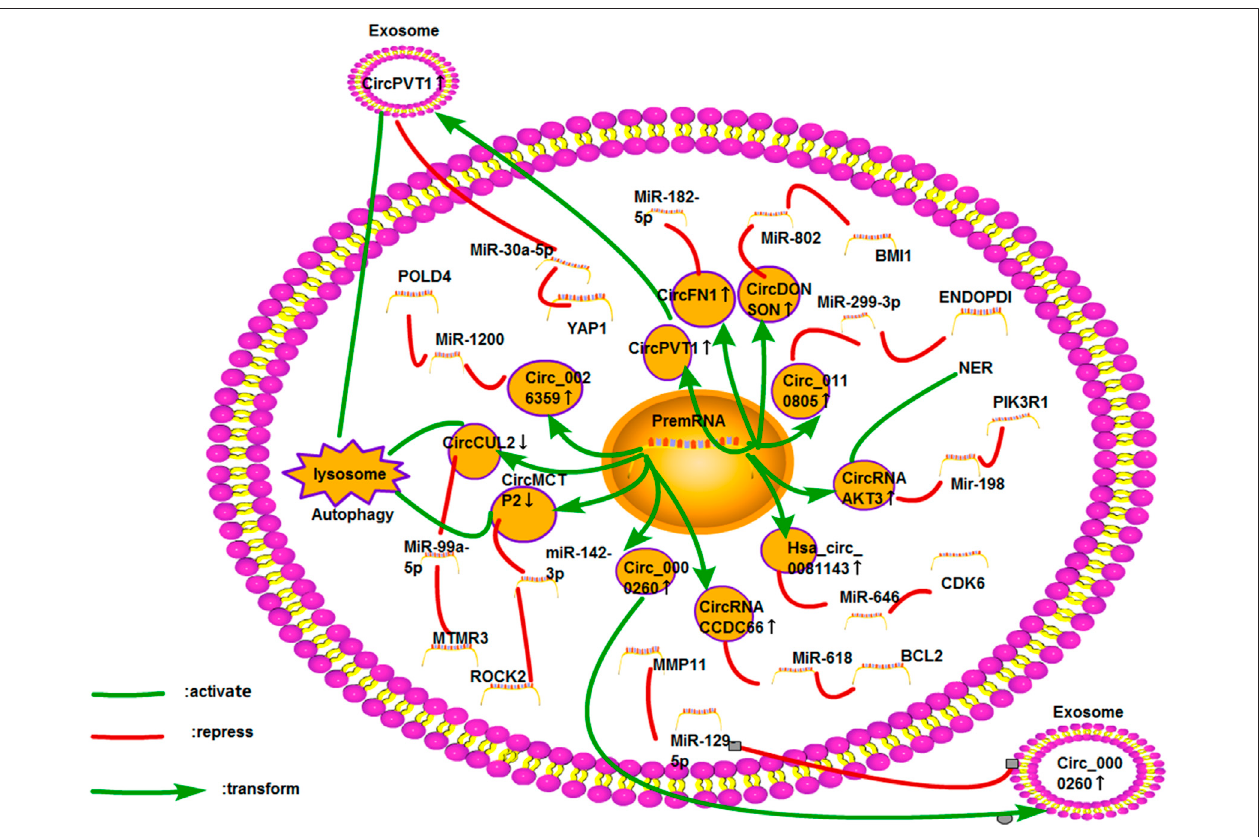
FIGURE 10 | Cisplatin resistance mechanism of circRNA in GC. At present, 11 circRNAs are found to be related to cisplatin resistance in GC. The mechanisms involved include ceRNA NET, exosomes, autophagy, and DNA damage and repair.